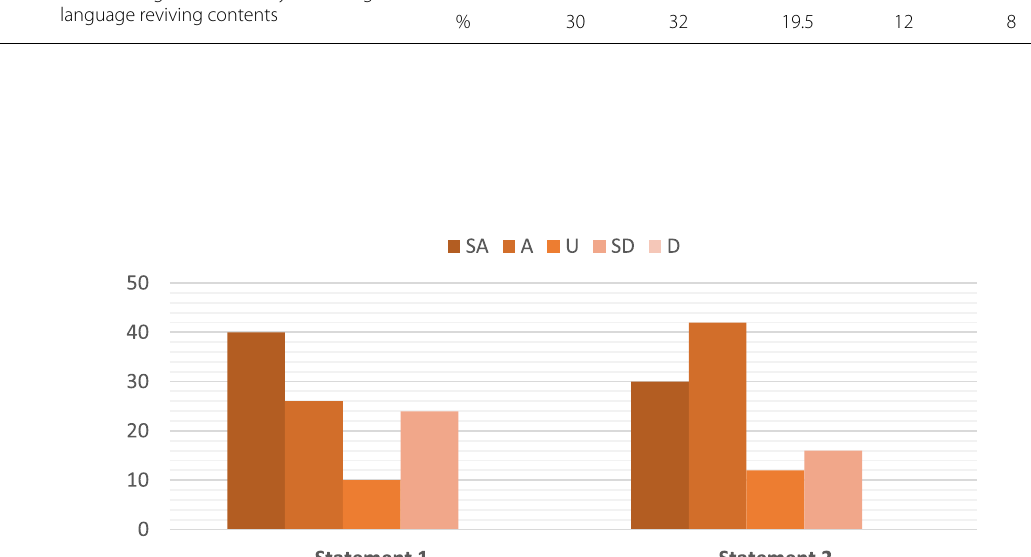
Fig. 13 Challenges in communicating through english language in the radio stations in